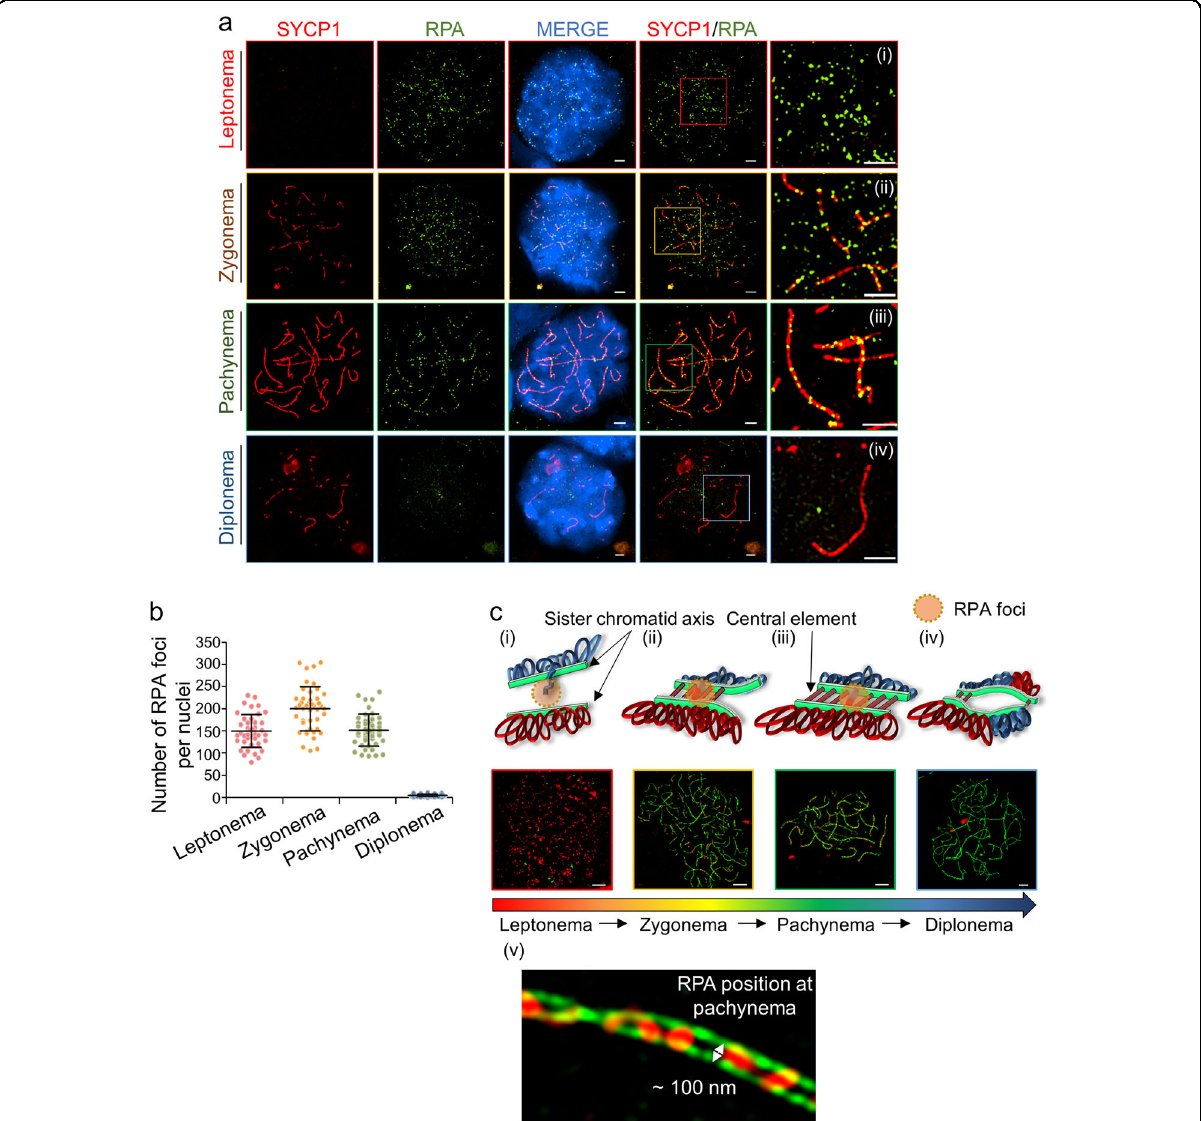
Fig. 6 Change in the number of RPA foci from leptonema stage to diplonema stage. a Spermatocyte stained with antibodies against SYCP1 (red) and RPA (green). Nuclei were con fi rmed by conventional microscopy, and each box is magni fi ed in (i) – (iv). (i) Leptonema stage, (ii) zygonema stage, (iii) pachynema stage, and (iv) diplonema stage. Bars represent 2.5 μ m. b The temporal distribution of RPA in prophase I stage. The RPA foci were quanti fi ed and analyzed with the Prism 5 software. The scatter plot shows the number of RPA foci per nucleus. Error bars represent mean ± SD. c A model for the structural change of meiotic chromosomes and RPA localization in prophase I (i – iv). SIM images of RPA foci and SC width in prophase I (v). As shown by the electron microscopy images in Fig. 1b, the distance between lateral elements is approximately 100 nm in the SIM